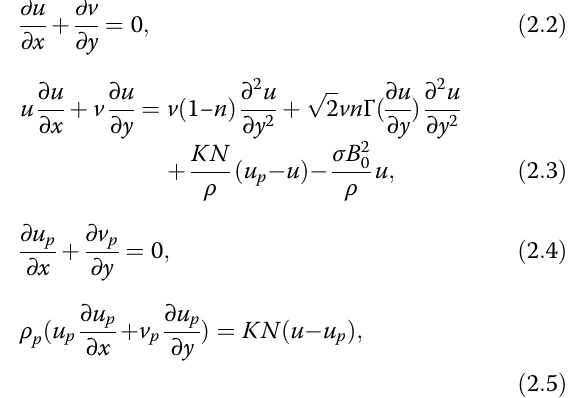
Table 1 Comparison table of skin friction coefficient ( We = n = 0) M Akbar et al. (2013) Fathizadeh et al. (RKF-45 method) (2013) (HAM method)